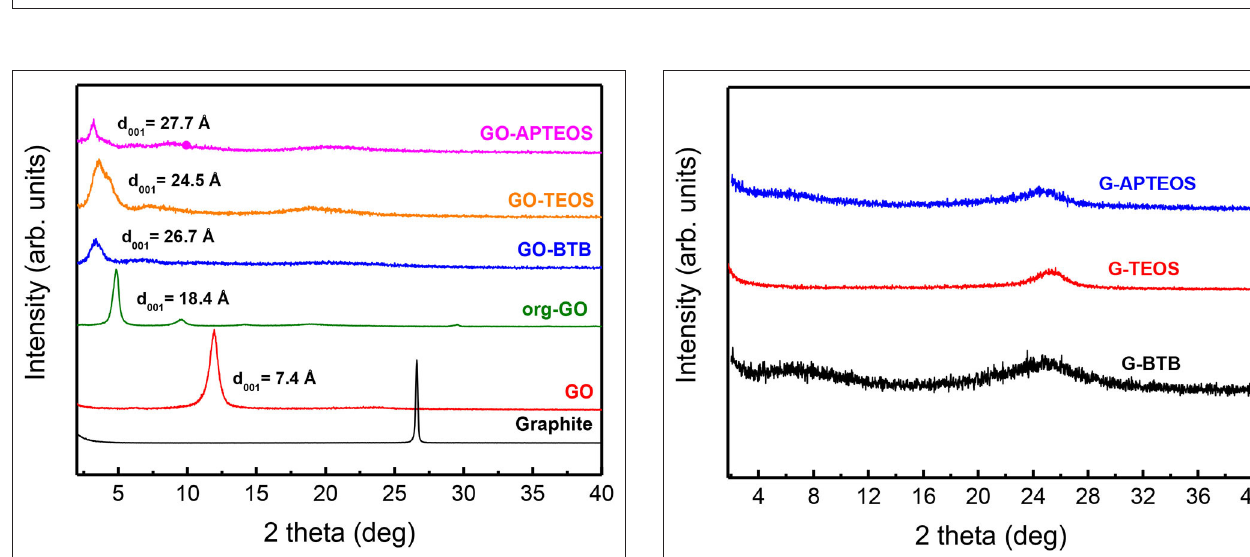
FIGURE 3 | XRD patterns of the heterostructures obtained after calcination of GO-APTEOS, GO-TEOS and GO-BTB at 370 ◦ C to yield G-APTEOS, G-TEOS and